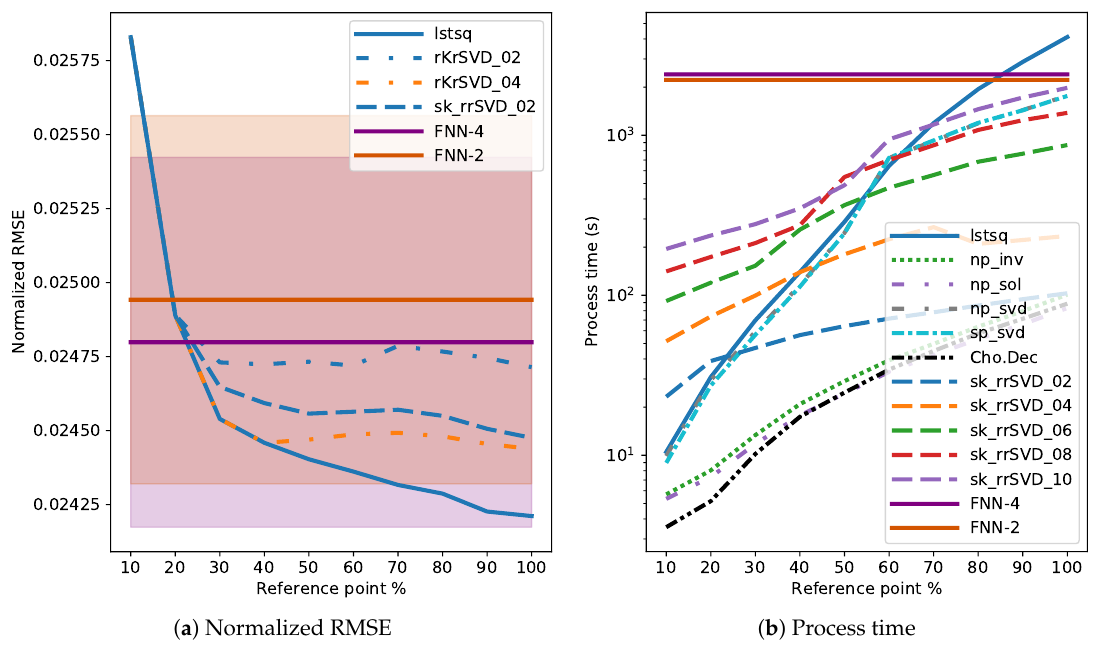
Figure A4. Normalized RMSE values ( a ) and process time in seconds taken to compute Equation (1) ( b ) as a function of reference point percentage for the Computer Activity dataset. In ( a ) for MLM, only methods that at any reference point percentage differ from Lstsq with Kruskal–Wallis H test are shown along Lstsq